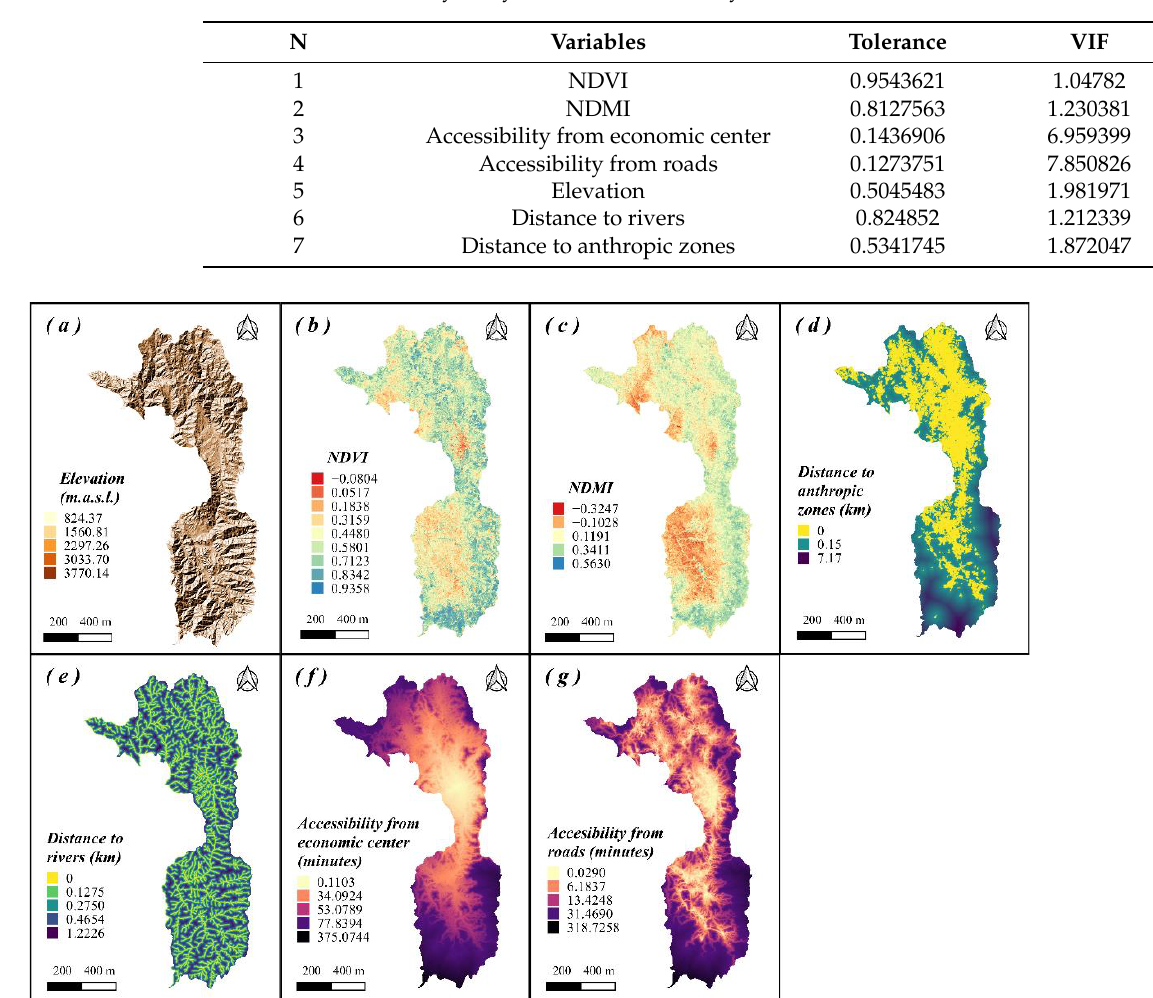
Figure 3. Final selection of predictor variables for the susceptibility model. Five of these variables are permanent: elevation ( a ), distance to anthropic zones ( d ), distance to rivers ( e ), accessibility from economic center ( f ) and accessibility from roads ( g ) and correspond to an estimate of the proximity to human activities that represent a risk of smoldering ignition. The two updateable layers are the NDVI ( b ) and NDMI ( c ) vegetation indices, which provide information on the state of moisture and vitality of the vegetation cover throughout the year in the study area.